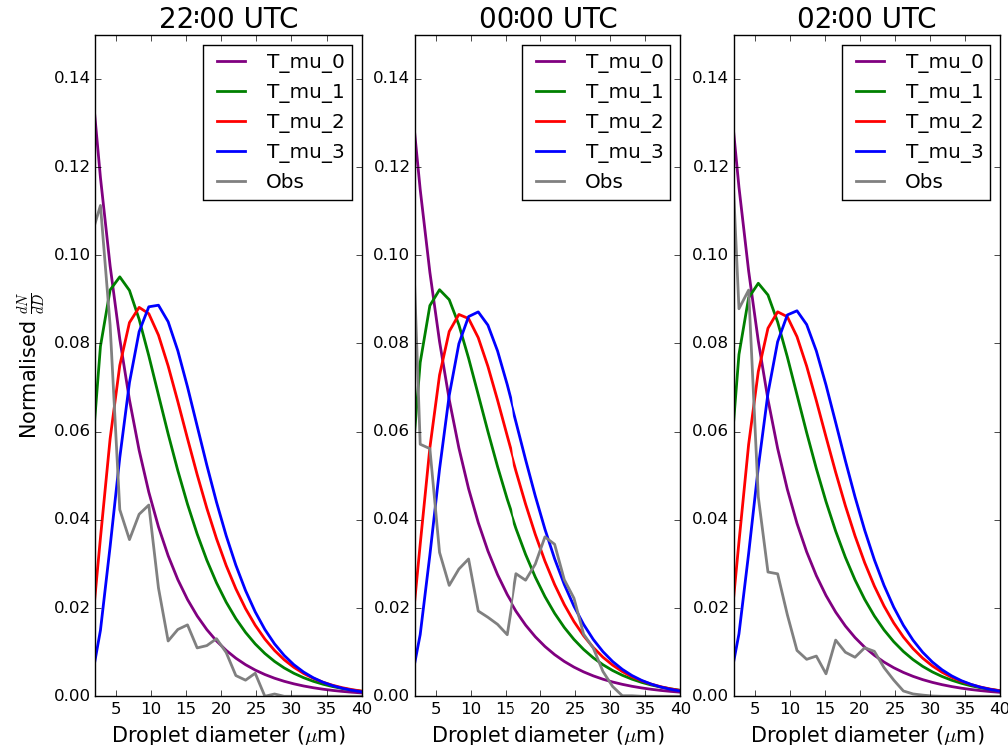
Figure B2. Cloud drop-size distributions for shape parameter simulations at 17:10, 18:00 and 22:00UTC at 2m. Green – T_mu_0; red – T_mu_1; dark blue – T_mu_3; grey –